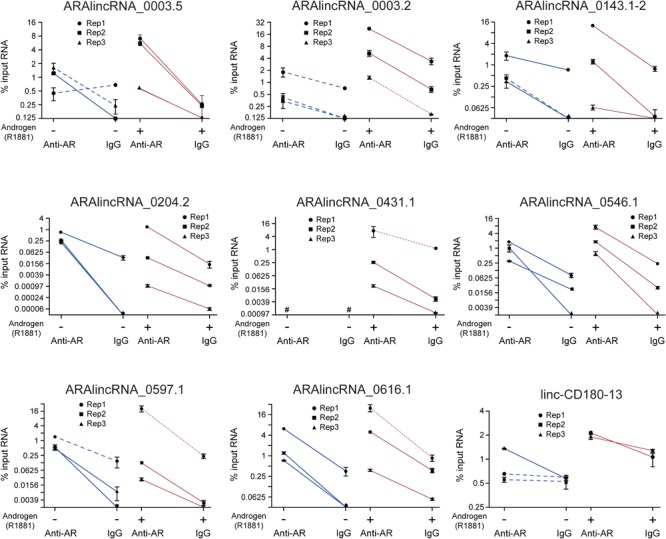
Validation by RIP-qPCR of a set of ARA-lincRNAs, which were detected in the RIP-seq assay as associated to AR. LNCaP cells treated with 0.1 nM androgen (red lines) or with vehicle control (blue lines) were assayed as indicated on the x-axis. The amount of the indicated lincRNA that was co-immunoprecipitated with antiAR antibody or with IgG from non-immunized rabbit (negative control) was measured by RT-qPCR in three different biological replicates (each represented with a different symbol), and the corresponding points for antiAR and IgG for each replicate are connected with a straight line. The results are shown as % input RNA (mean ± SEM) of three technical replicates for each individual biological replicate. For the four lincRNA genes in the experiment with androgen whose experimental points are connected with red dotted lines, the amount of RIP material was only enough for two technical replicates each, and the enrichment t-test was not applied. Red and blue solid lines = significant difference between antiAR and IgG (p < 0.05); blue dashed lines = non-significant difference, t-test.